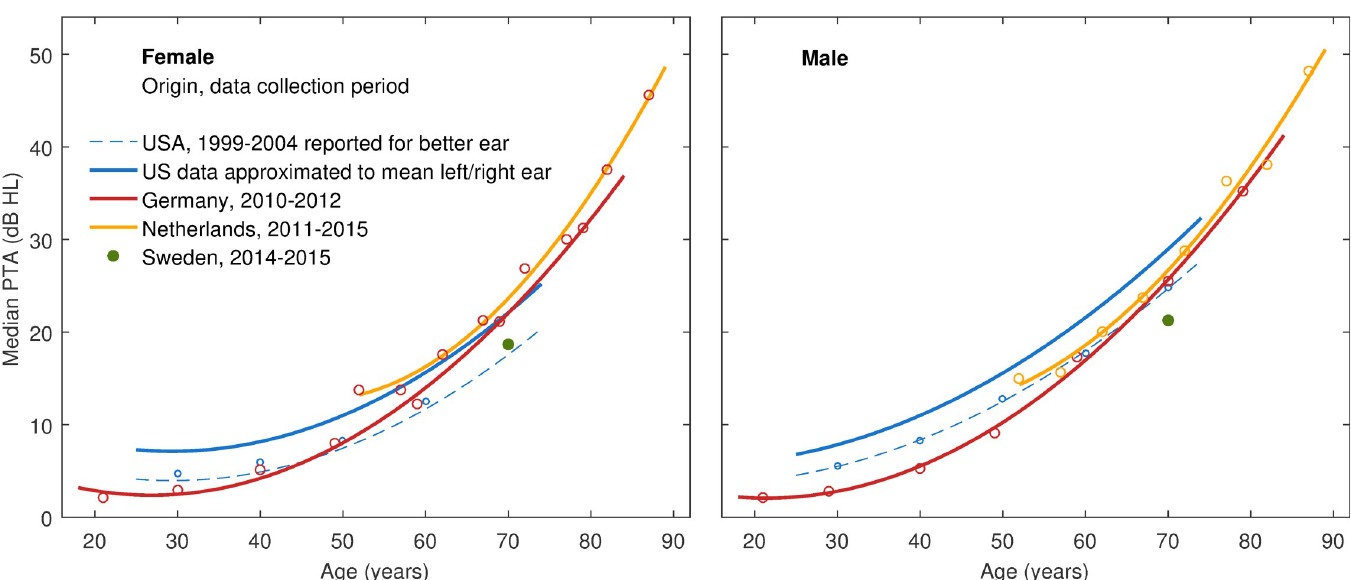
Fig 2. PTA as a function of age. Comparison of median PTA from averaged left and right ear in the German sample to published results from international studies for females (left panel) and males (right panel). Median HTL reported for the US study referred to the better ear on a frequency-by-frequency basis and was adjusted using Formula